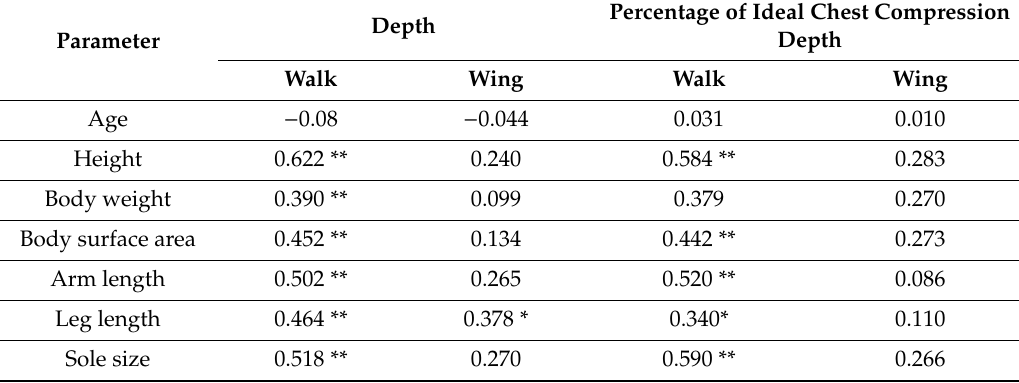
Table 2. Correlation coe ffi cients between the rescuer’s size and chest compression quality, considering chest compression depth and percentage of ideal chest compression